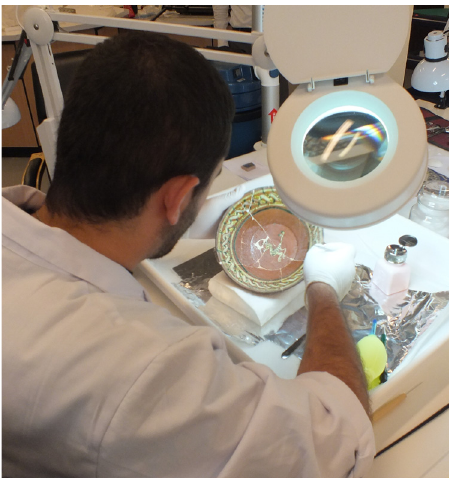
Fig. 2: An MSc Conservation Studies stu- dent at work on an object in the UCL Qatar conservation